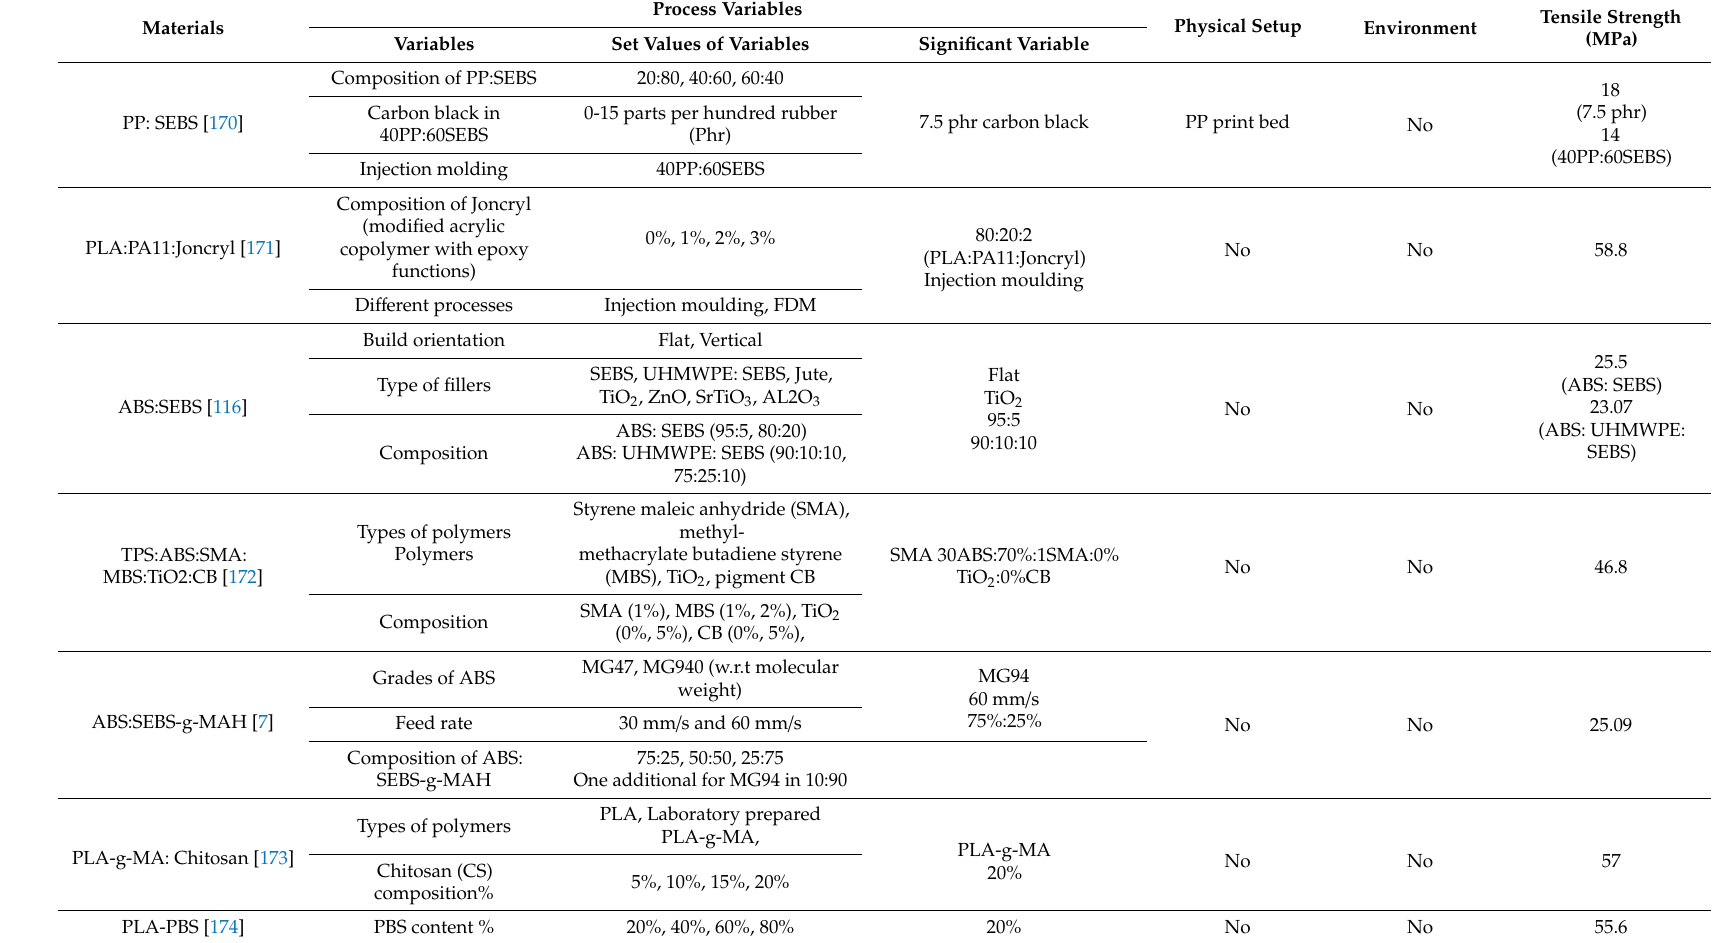
Table 6. Process factors for achieving high tensile strength for blend